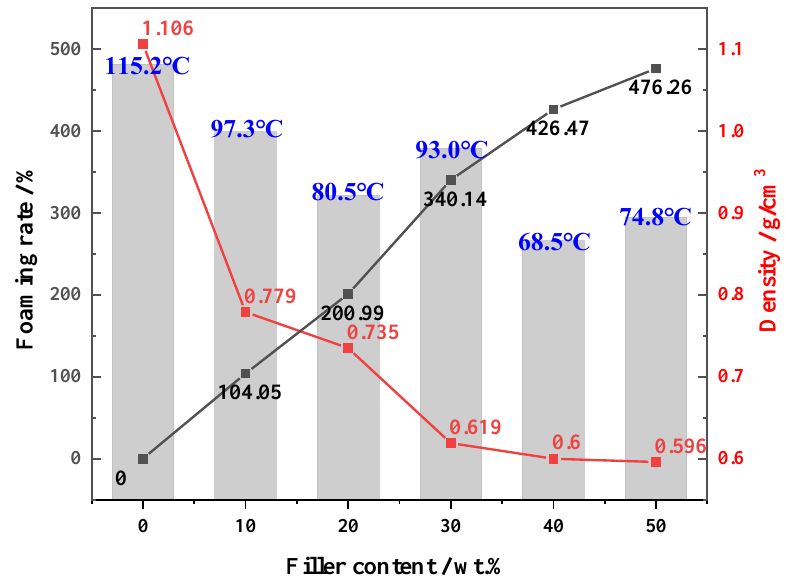
Figure 4. The foaming rate, density, and maximum reaction temperature of the PU and PU/FA composite.